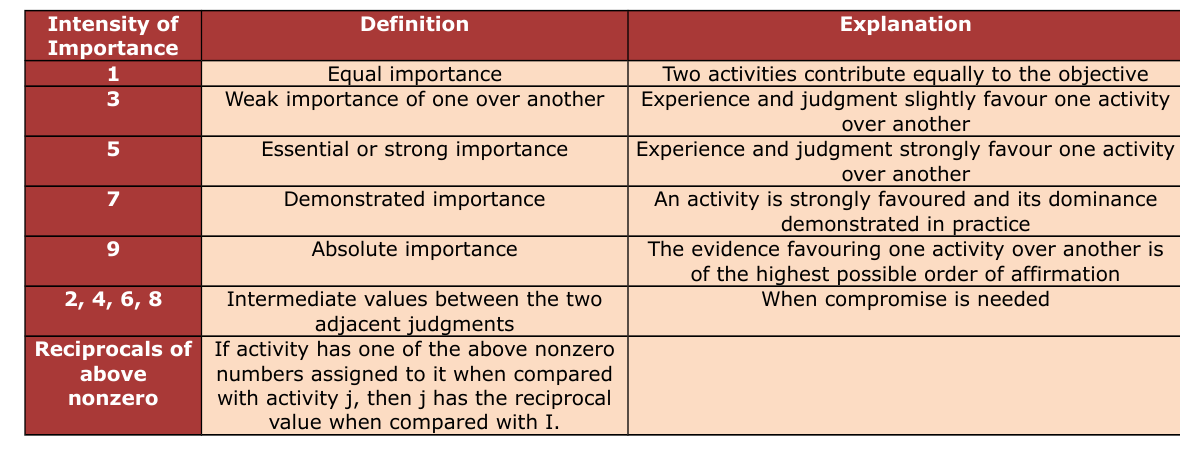
Table 1. Scale of Relative Importance (Saaty,